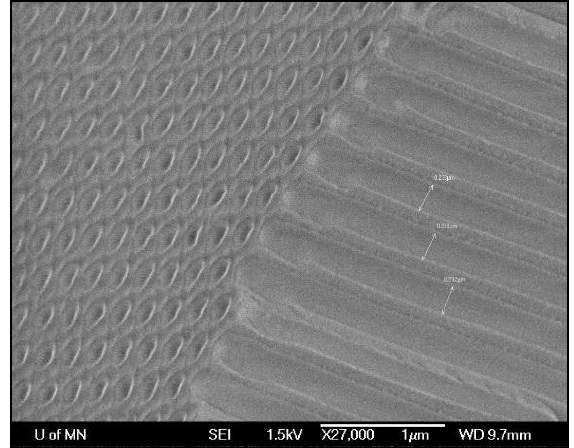
Figure 7. Anodic aluminum oxide template [19].